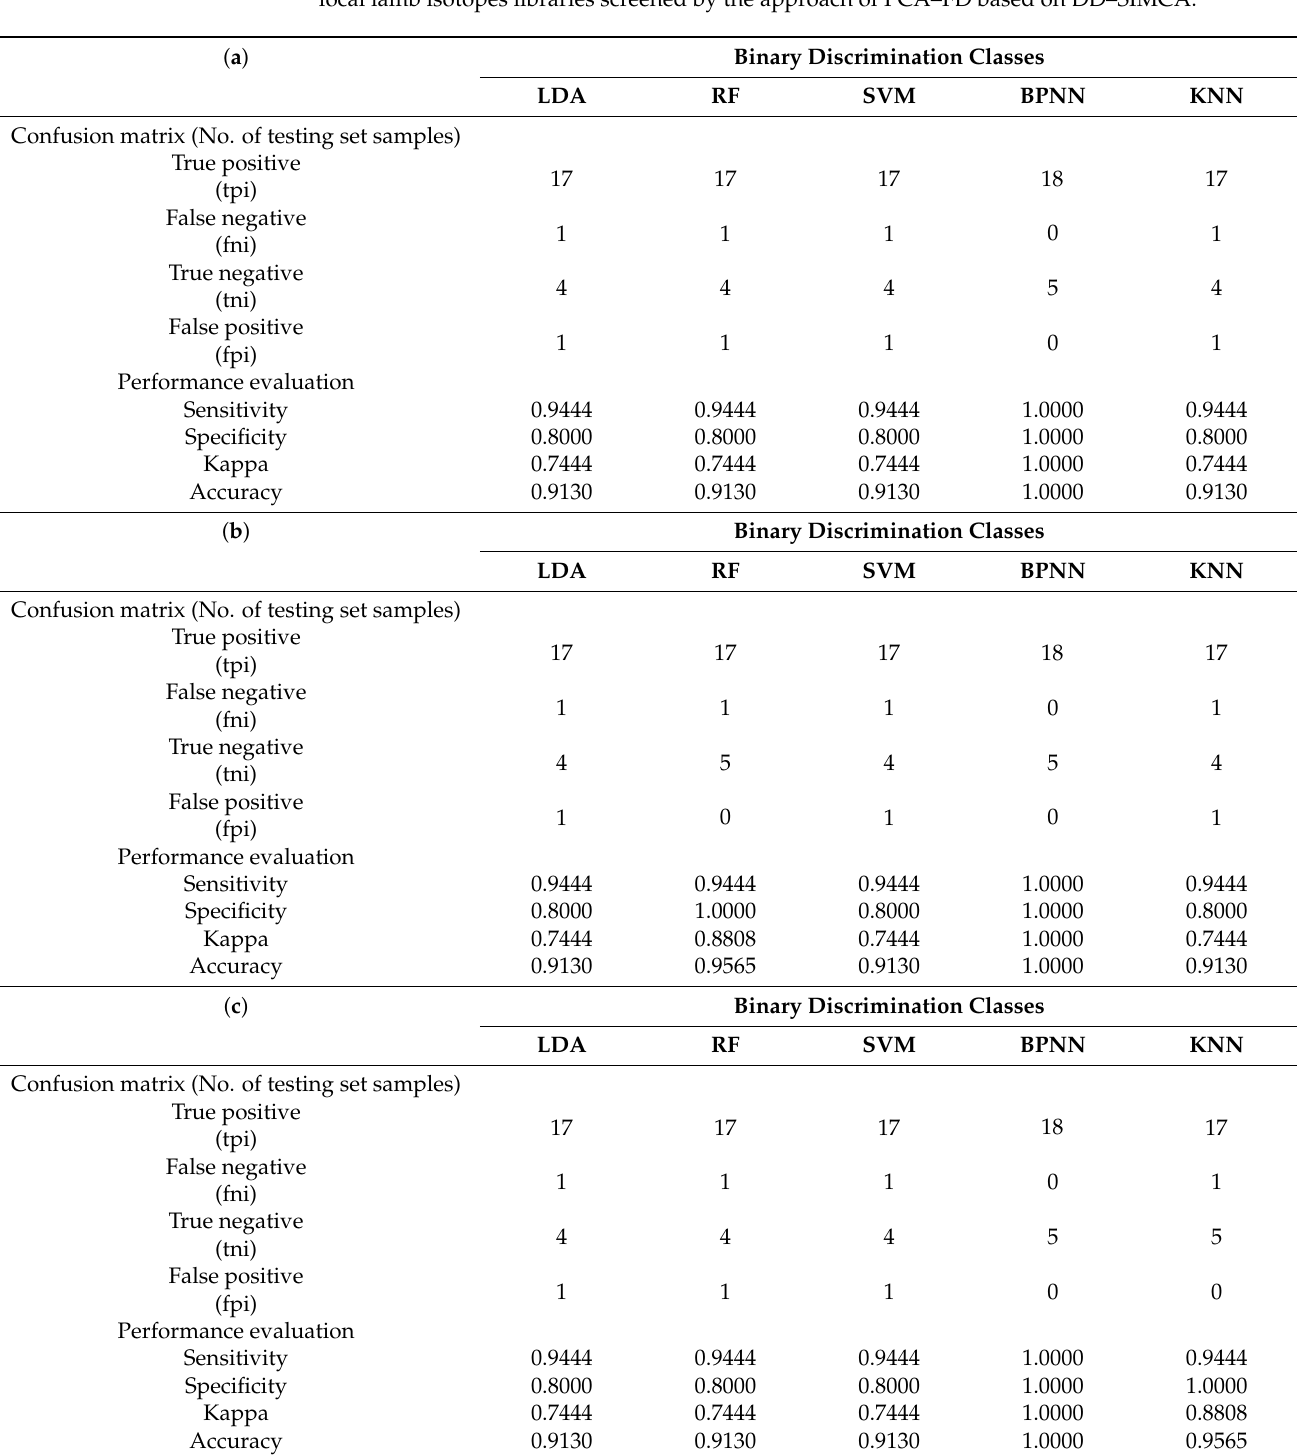
Table 3. Origin classification results of applying the 5 models to the testing set lambs according to (a) the global lamb isotopes libraries, (b) the local lamb isotopes libraries screened by AKS, and (c) the local lamb isotopes libraries screened by the approach of PCA–FD based on